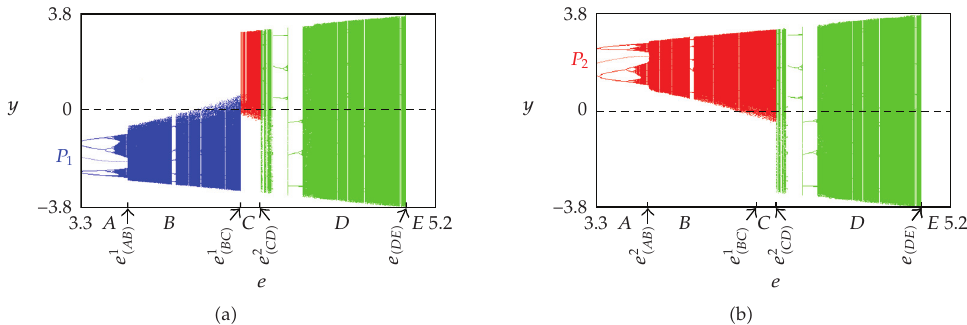
Figure 10: Bifurcation diagrams. The b.d. in (cid:5) a (cid:6) corresponds to an initial condition close to P 1 , whereas the b.d. in (cid:5) b (cid:6) assumes an initial condition close to P 2 . The green portion of the diagrams is the same for any initial condition (cid:5) except for those leading to divergent trajectories (cid:6)